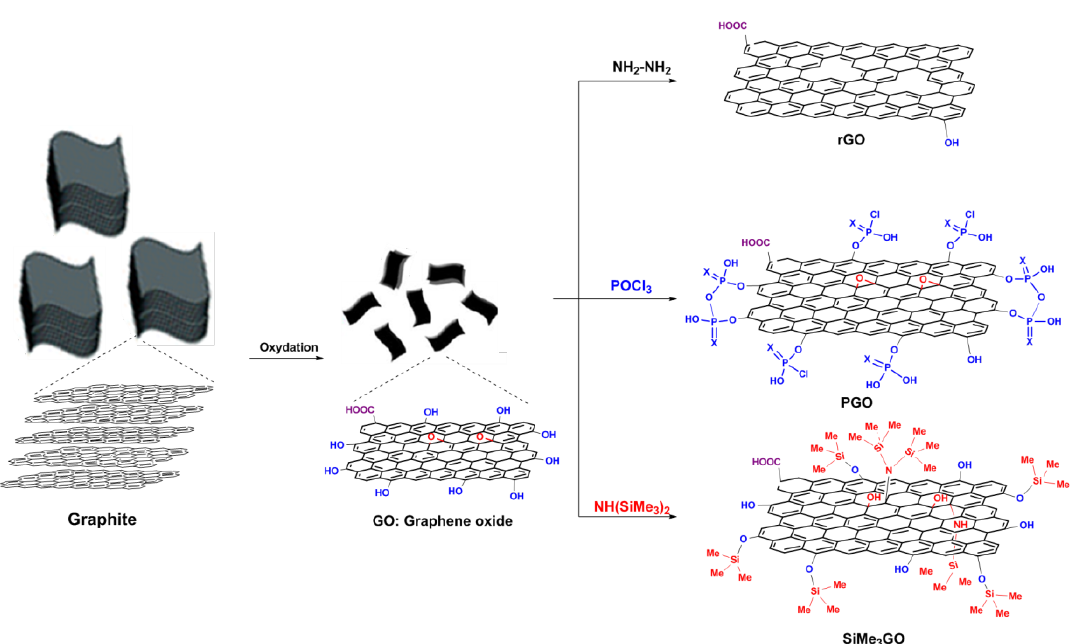
Figure 1. Chemical pathway illustrating the preparation of four fillers (graphene oxide ( GO ) , reduced GO ( rGO ) , phosphorylated GO ( PGO ), and trimethylsilylated GO ( SiMe 3 GO ) from